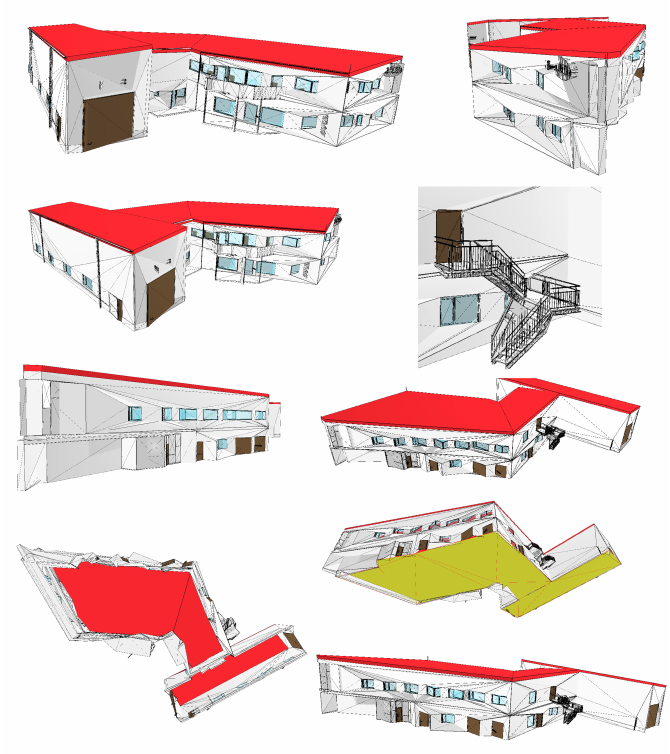
Figure 8. Views of the Myran model converted to CityGML by the test FME-RVTr-L1, visualized in azul.